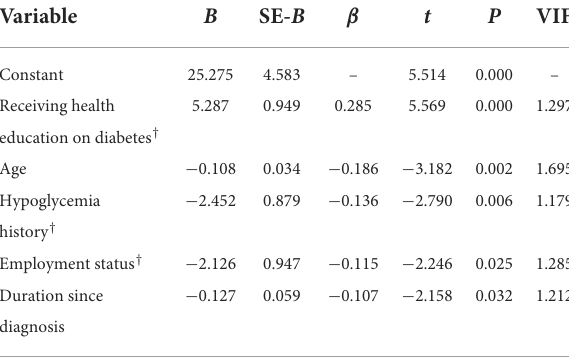
TABLE 4 Predictors of fear of progression among type 2 diabetic patients ( n =